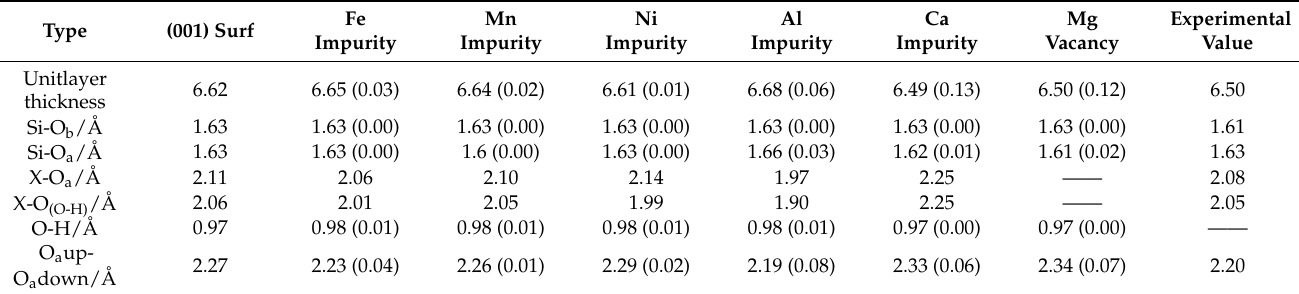
Table 2. Surface parameters of ideal talc (001) and with point defects.